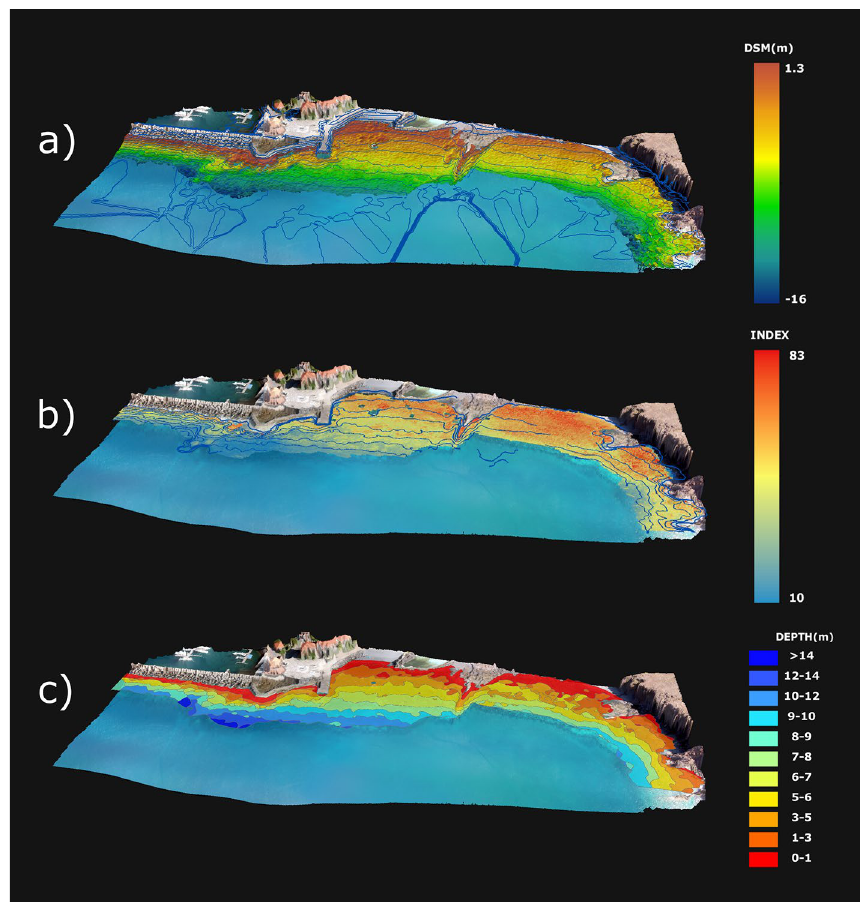
Figure 2. Optically Derived Bathymetry estimation from aerial imagery mosaic and photogrammetric generated digital surface model (DSM); with: ( a ) DSM depth variation (m) over rocky bottom and DSM contours with 2-m interval (blue lines); ( b ) combined (normalized) ln-RED index and ratio of ln-Green to ln-Blue index and smoothed, contextually edited, depth contours used for Optically Derived Bathymetry estimation using OBIA (see above), and; ( c ) resulting estimated depth classes. Map and figure generated in ESRI ArcGIS Desktop